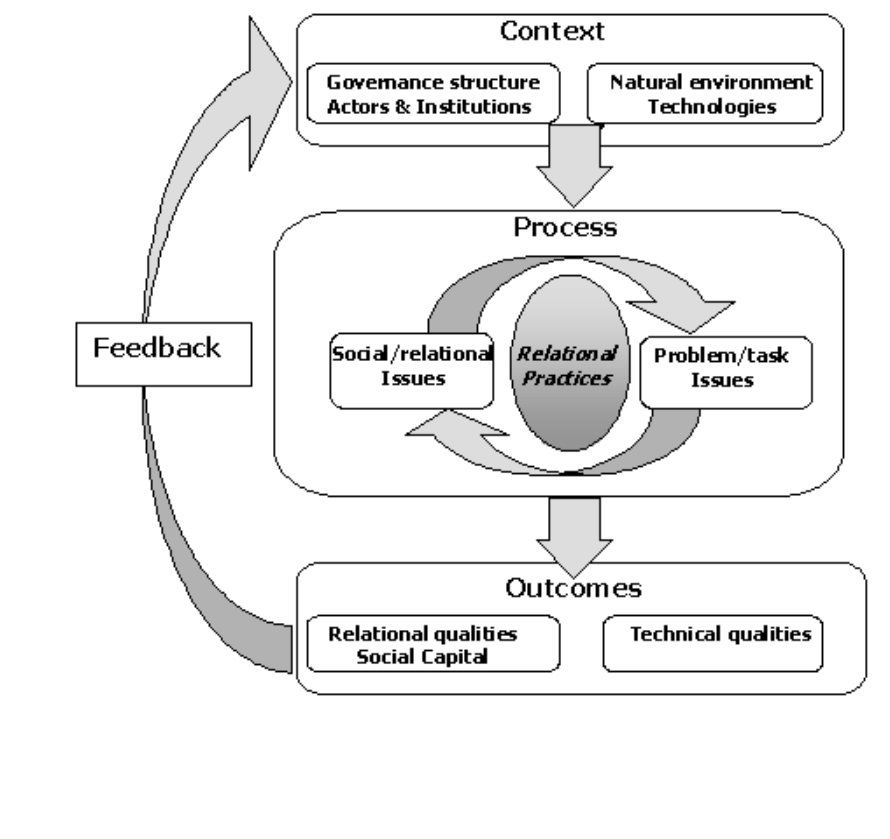
Fig. 3 . Conceptual framework for social learning in resources management. In the center are multiparty processes that are influenced by the context in which they are embedded and that produce outcomes that may lead to changes in the context, and thus to a cyclic and iterative long-term process of